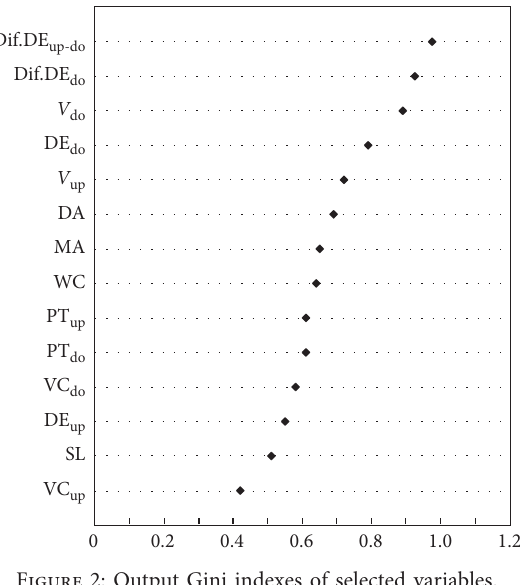
Figure 2: Output Gini indexes of selected variables.